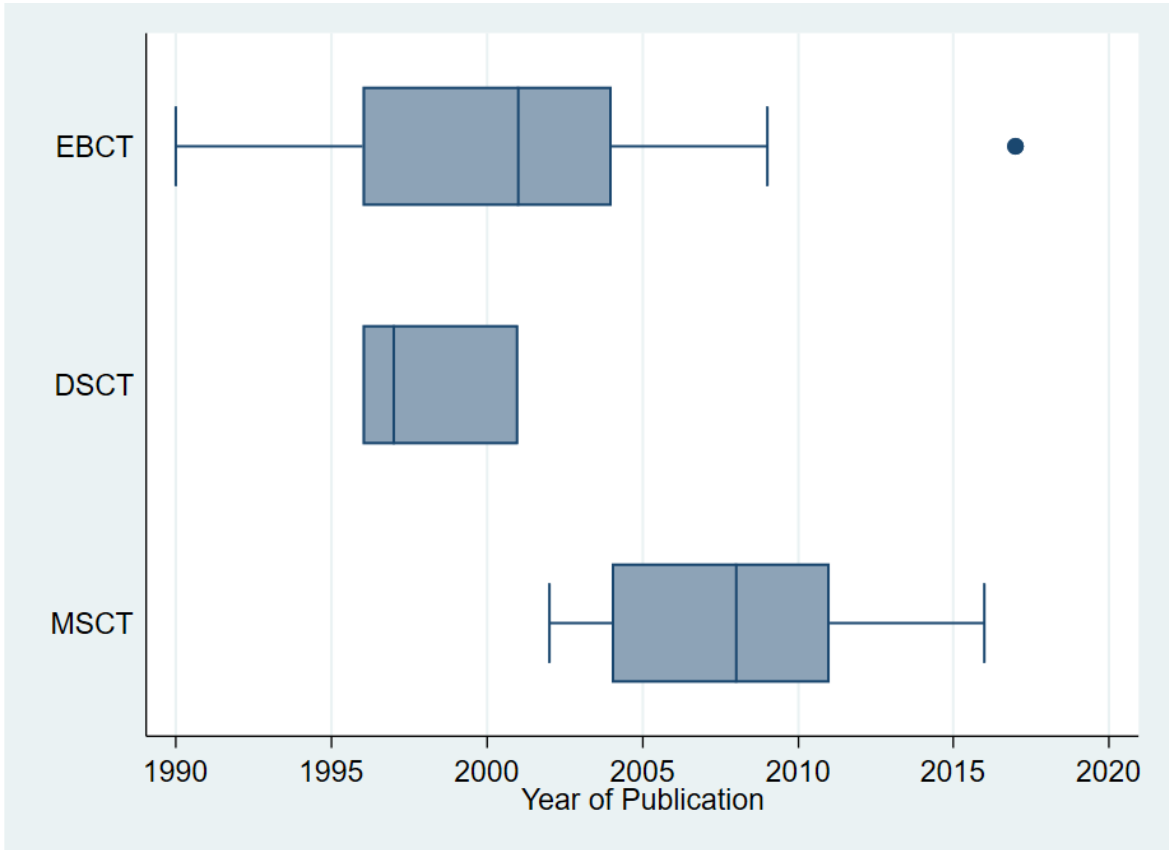
Figure 1. Type of CT scanner technology used in the included studies.